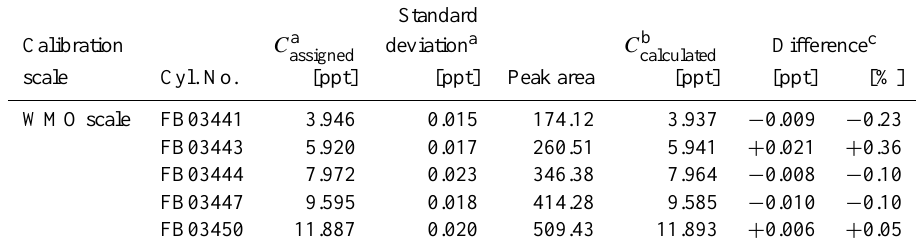
Table 2. Analytical results of SF 6 standard gases from the NOAA.